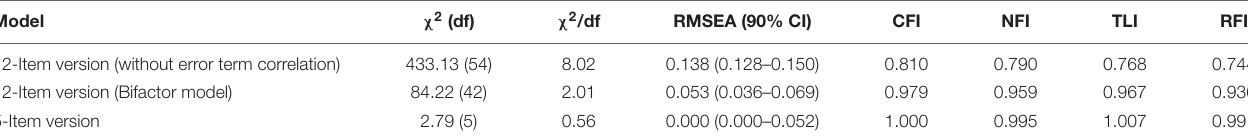
TABLE 4 | Results of the confirmatory factor analysis.